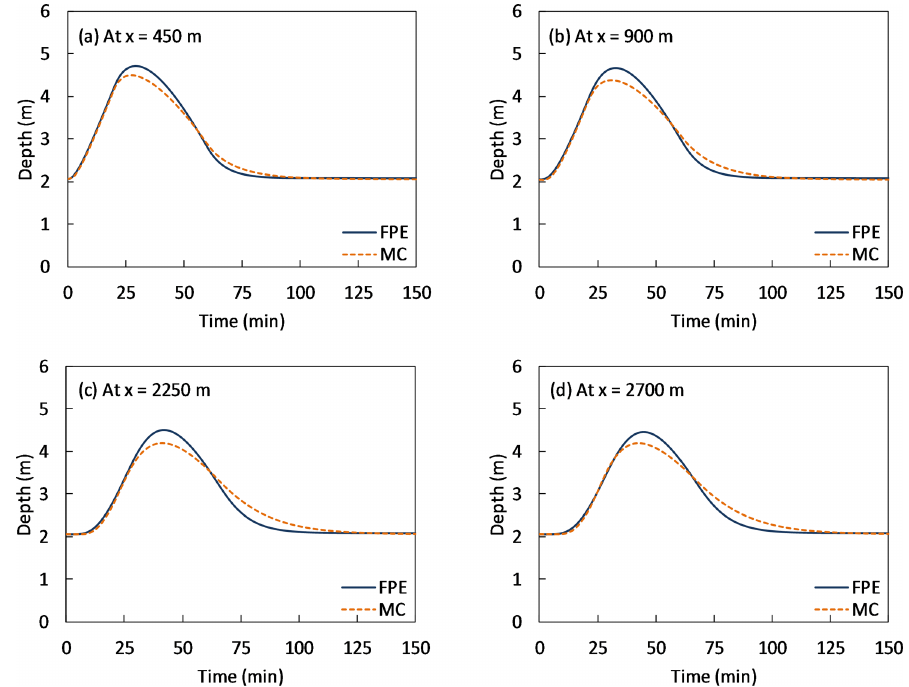
Figure 5. Comparison of the ensemble average flow depth obtained by the FPE methodology and the MC approach as a function of time, at different channel